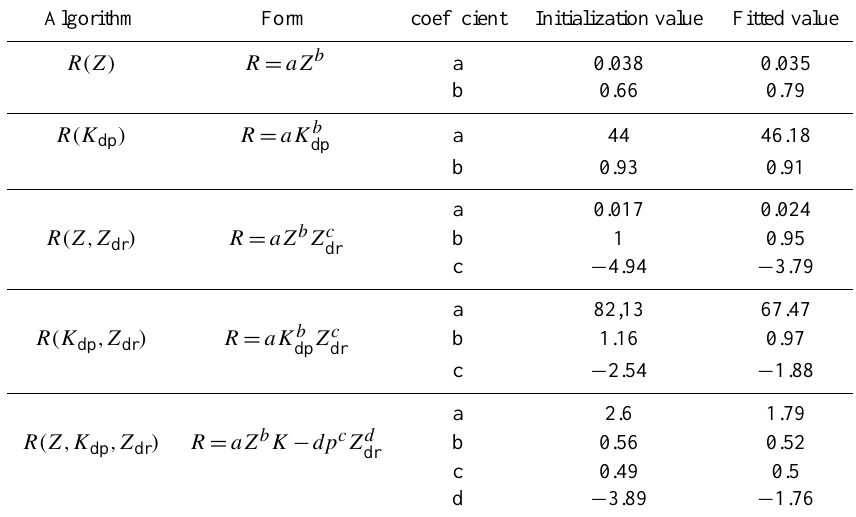
Table 2. Initialization and fitting coefficients for the different rain rate algorithms.